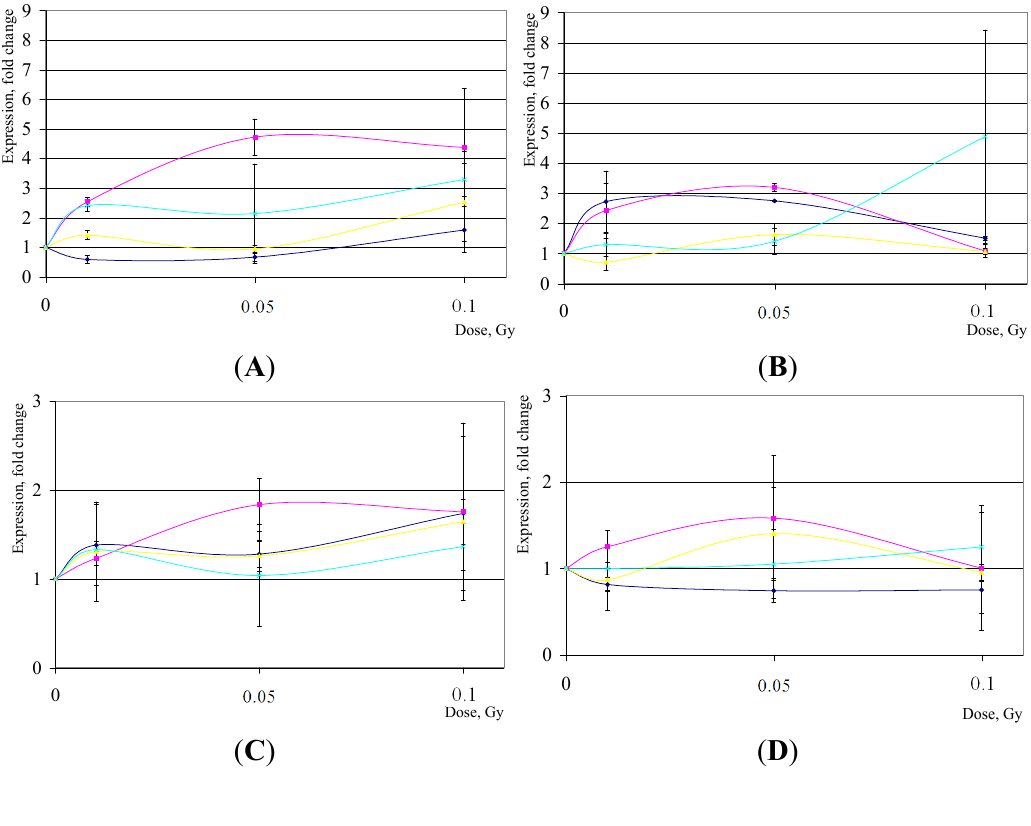
Figure 1. CDKN1A ( A , B ) and GADD45A ( C , D ) gene expression changes in hESCs after LD of IR exposures. Shown are mean relative quantities (±SD) for cell cultures post treatments compared to sham-IR. In violet, H1 hESC line; in pink, H7; in yellow, H9; and in blue, H14. ( A , C ), gene expression changes 2 h post-IR; ( B , D ), 16 h post-IR,